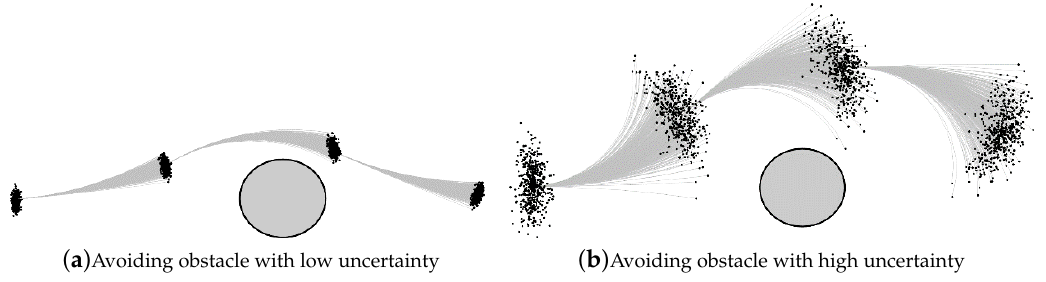
Figure 1. Illustration of the motion uncertainties during obstacle